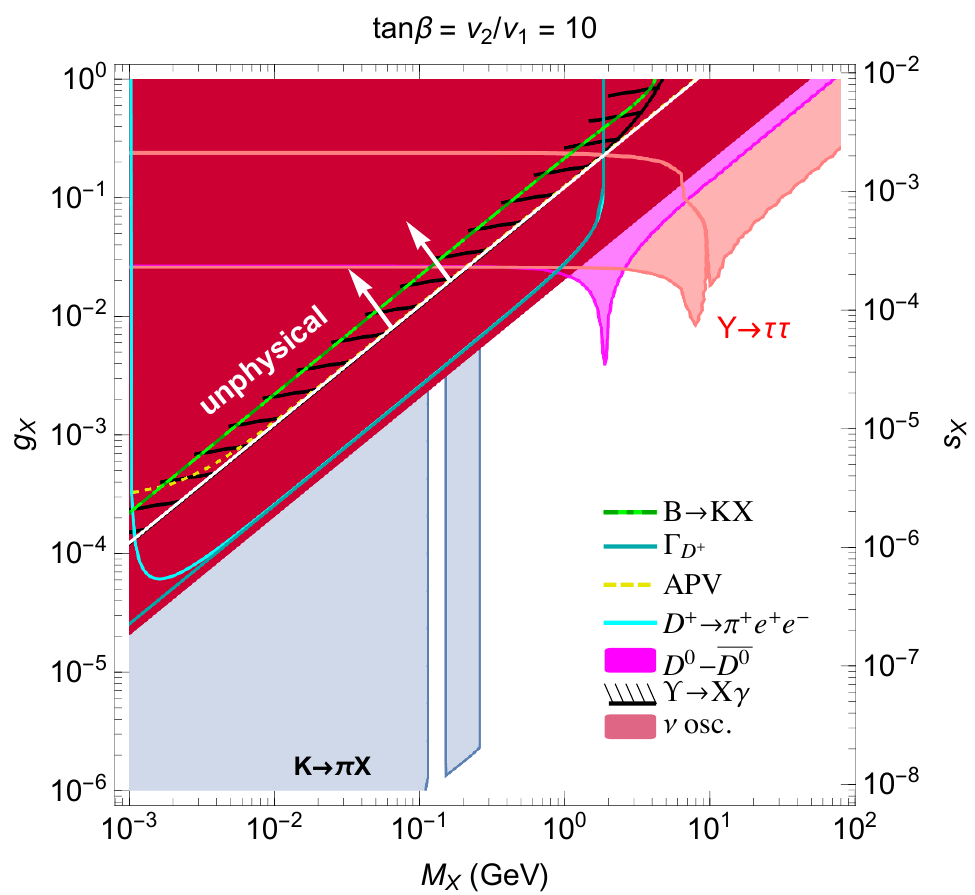
Figure 2. Constraints on the U(1) (3) gauge boson mass M X and coupling g X for tan (cid:12) = 10. B (cid:0) L For convenience the X (cid:0) Z mixing, s X , is also shown. Notice that for a given g X , the mass of the gauge boson M X is bounded from below, so there is an unphysical region in the upper left corner of the M X (cid:2) g X plane (delineated by the white line). The \ (cid:23) osc." bound comes from non standard interaction e(cid:11)ects (matter potential) on atmospheric neutrinos. \APV" refers to